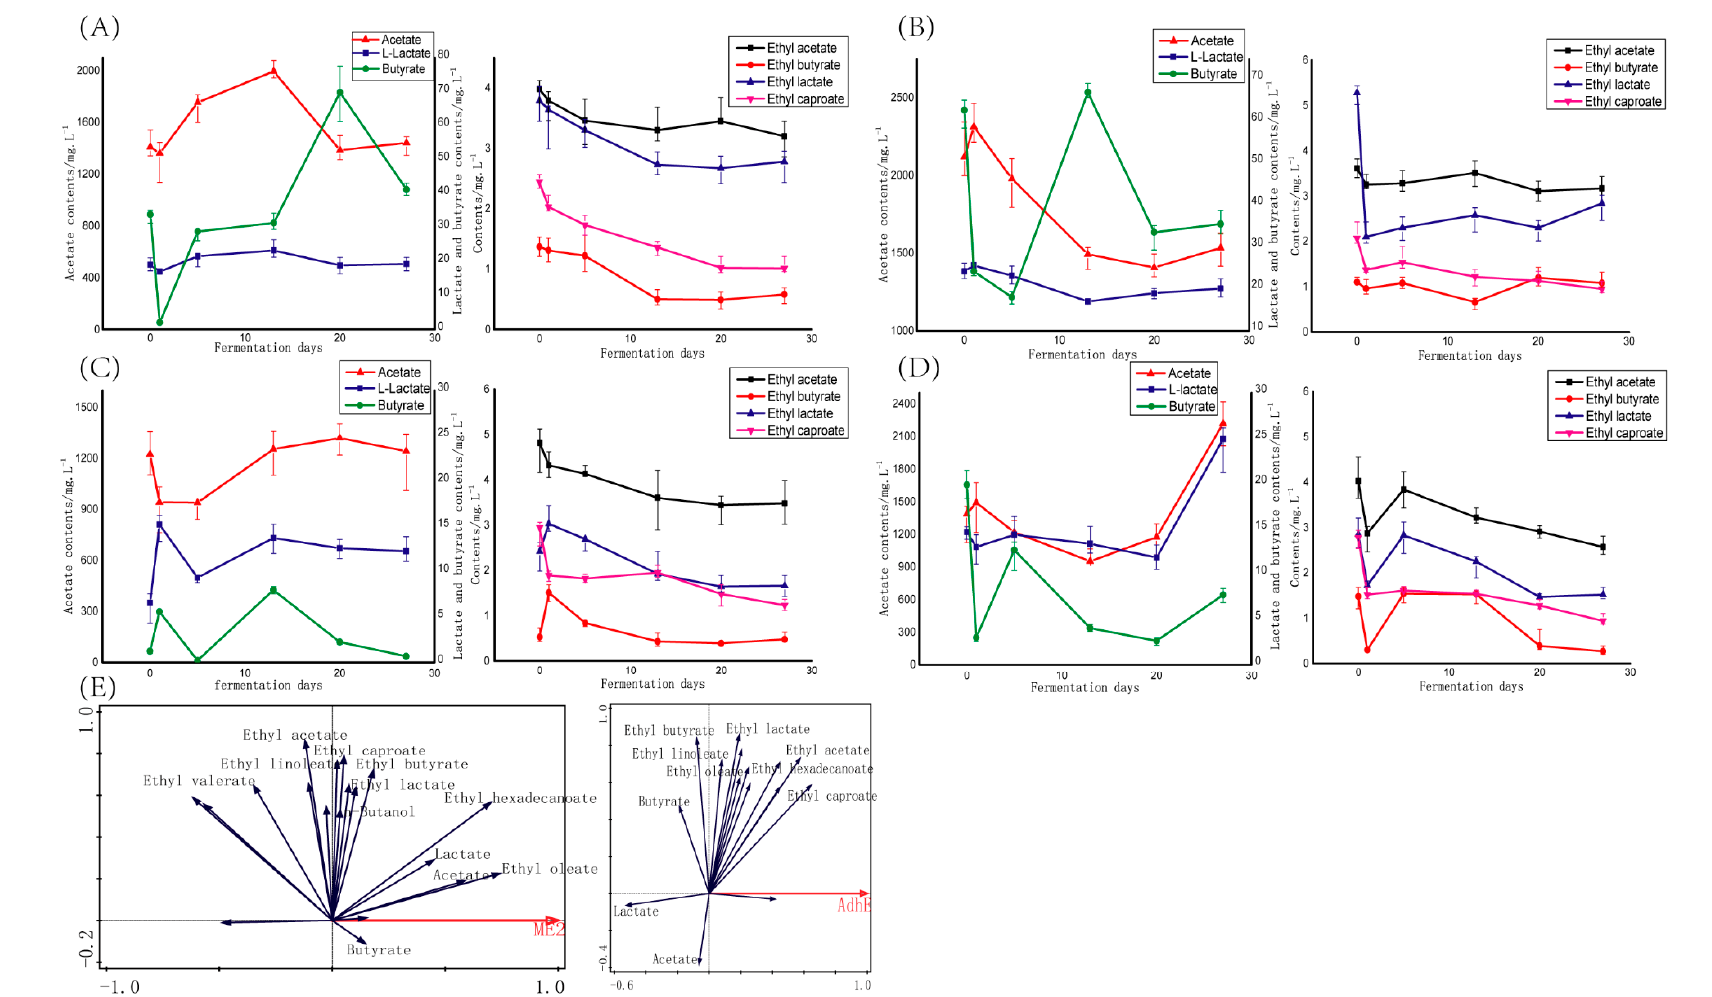
Figure 2. Effects of functional microorganisms on major flavor substances during liquid fermentation. ( A – D ) were changes of key flavor substances during liquid fermentation after RsM31, RsM42, CtA6 and LbA7 inoculation, respectively. ( E ) was redundancy analysis of gene ME2, adhE and main flavor substances.